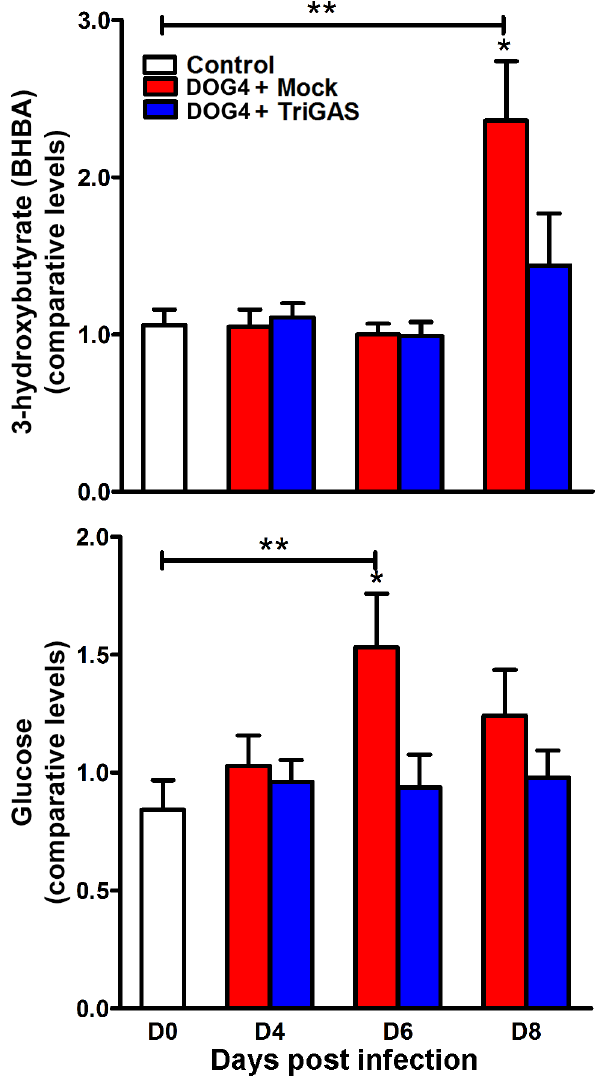
Figure 3. Energy metabolites 3-hydroxybutyrate (BHBA) and glucose increase in the CNS during the course of WT RABV infection. Mice were infected i.n. with 10 5 FFU of DOG4 and 4 hr later either mock treated i.m. with PBS or treated with 10 7 FFU of TriGAS. An additional group of uninfected, untreated mice served as a reference. Six mice per group were euthanized for each time point, and the levels of BHBA and glucose were determined via LC-GC/MS-MS2 as described in Materials and Methods. The results are presented as comparative levels ( + / 2 SE). *p , .05, **p , .01.